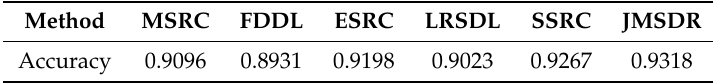
Table 2. The recognition accuracy on four-class target by different